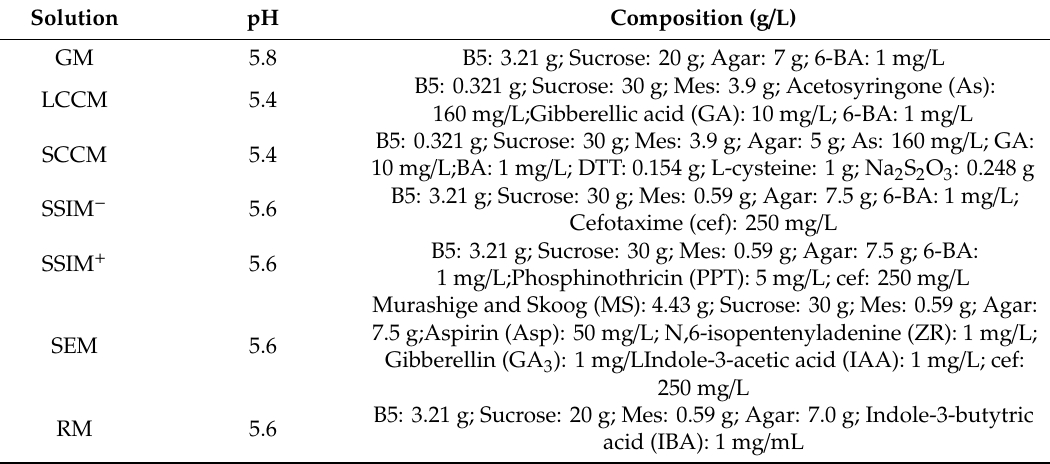
Table 2. Media used for soybean cotyledonary explant